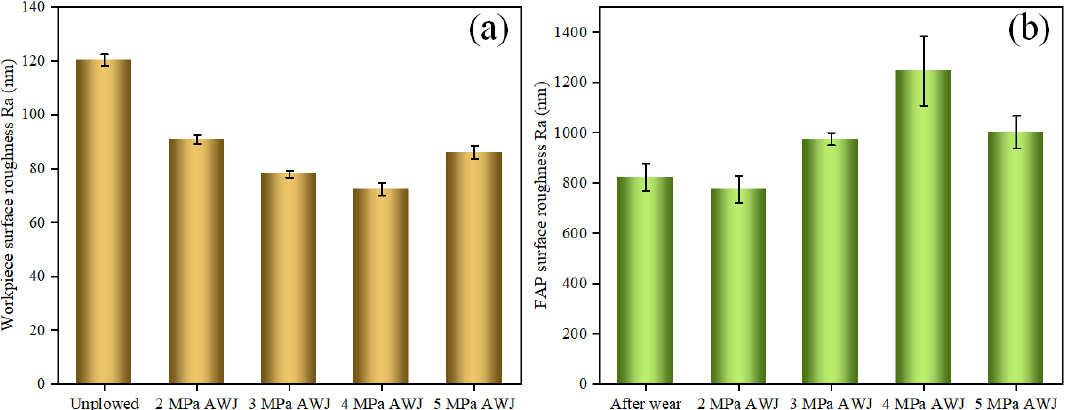
Figure 10. Workpiece morphology of FAP lapping with AWJ dressing under four pressures: ( a ) be- fore lapping; ( b ) after lapping.